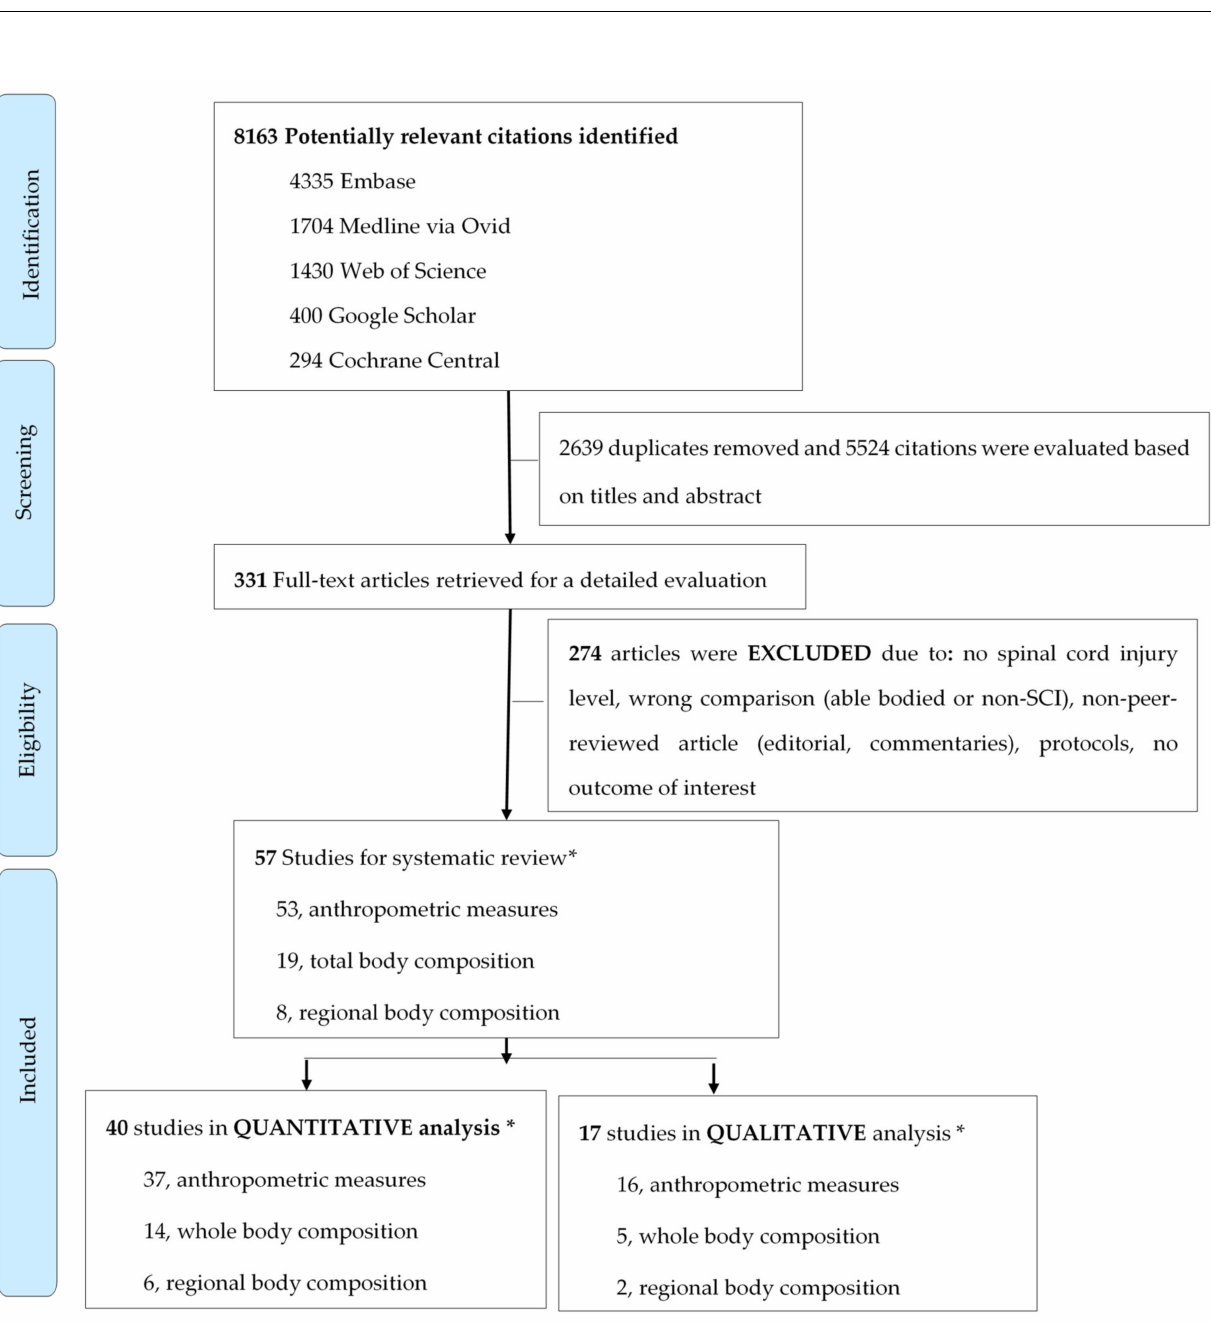
Figure 1. Flowchart of study inclusion (SCI: spinal cord injury; * Some studies reported information on multiple outcomes. Thus, the number of studies per outcome exceeds the total number of available